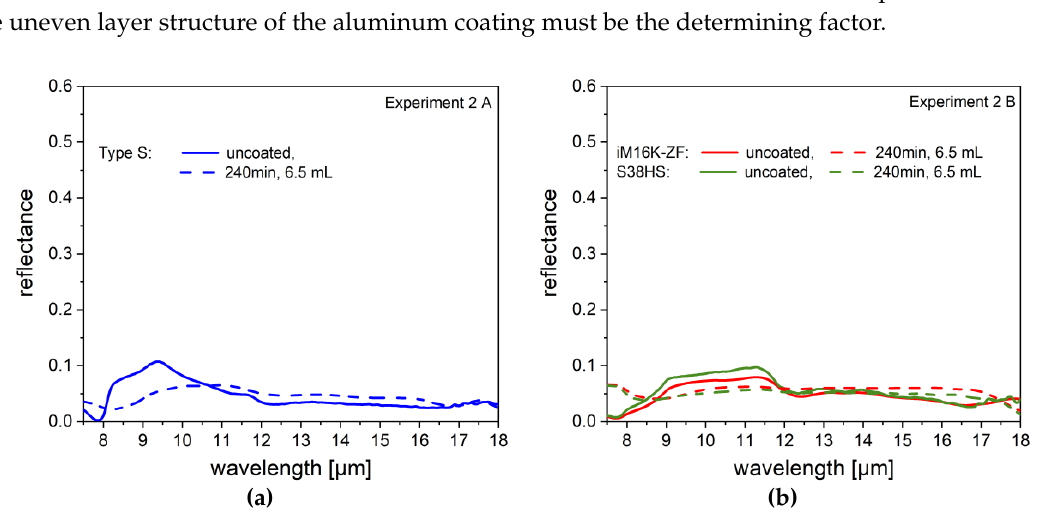
Figure 16 . ( a ): Results of the reflection measurements of the LPD-coated SMGS (Experiment 2 A) with an amount of 10 g. No increase in reflectance occurs. ( b ): Results of the reflection measurements of the LPD-coated MHGS (Experiment 2 B) with a volume of 6.5 mL. Further, no increase in reflection occurs.